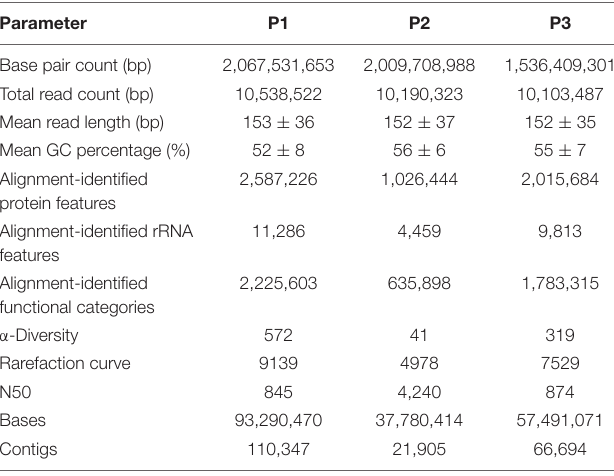
TABLE 1 | Sequence-read statistics from metagenome data obtained from each sampling site (P1, P2, and